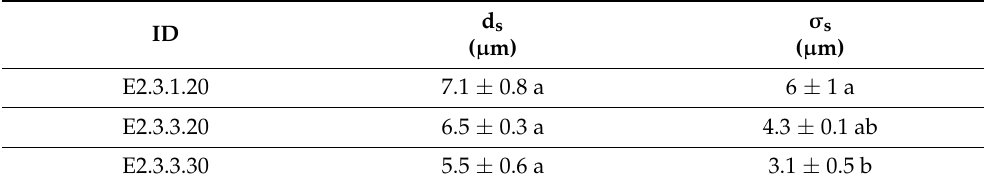
Table 5. Mean diameter d s (Equation (4)) and standard deviation σ s (Equation (5)) of the log-normal distribution. Different letters, for the same parameter, refer to significantly different